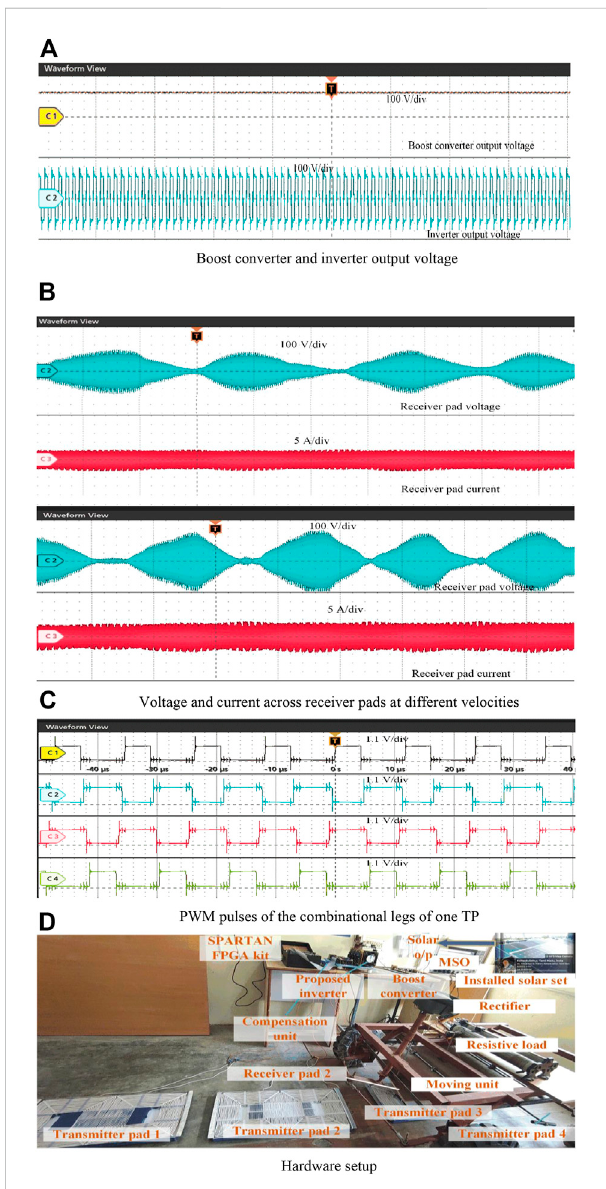
FIGURE 13 Hardware and its output waveforms. (A) Boost converter and inverteroutputvoltage, (B) Voltageandcurrentacrossreceiverpadsat different velocities, (C) PWM pulses of the combinational legs of one TP, (D) Hardware